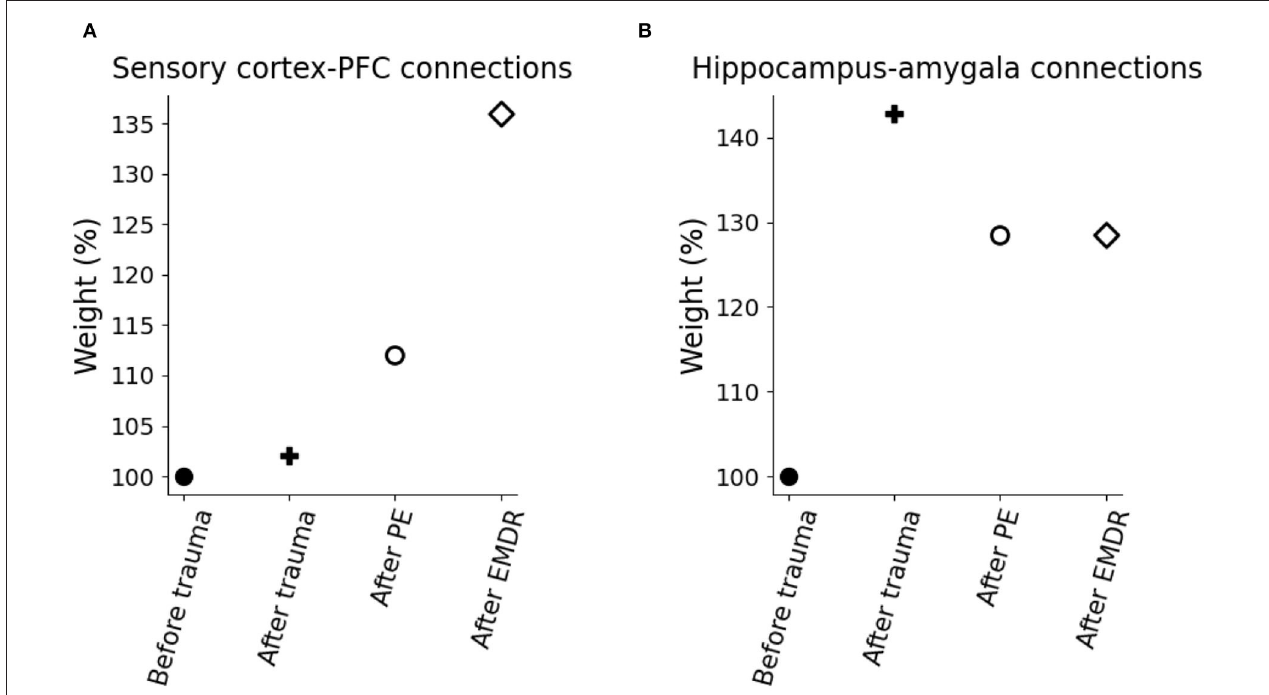
FIGURE 9 | Model weight modification due to trauma and therapy. (A) Connection weights linking the sensory cortices to the PFC. (B) Connection weights linking the hippocampus to the